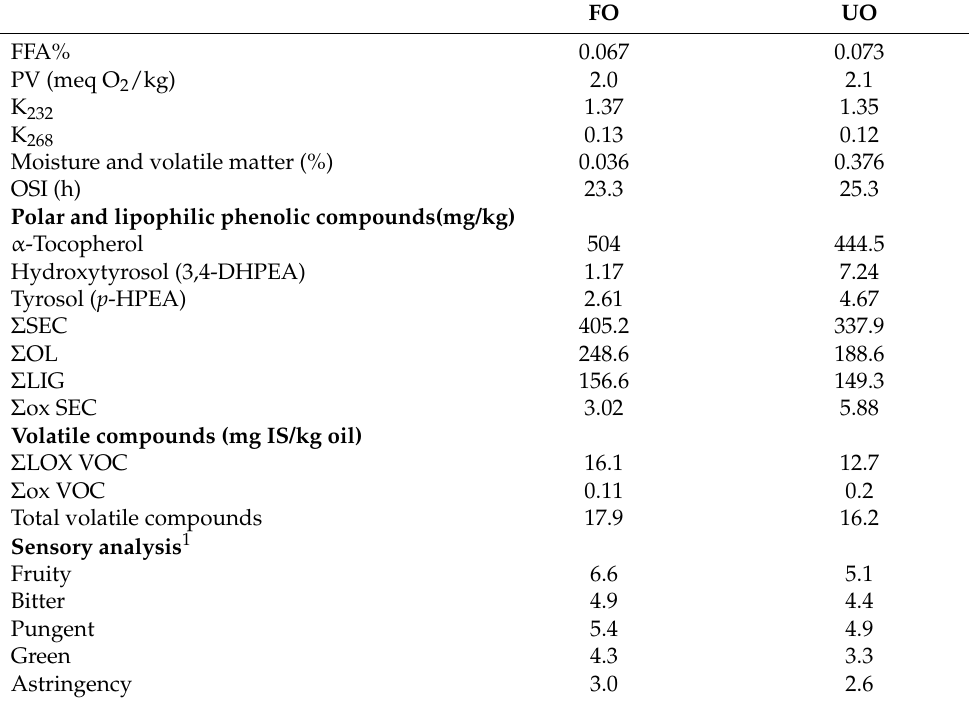
Table 1. Selected parameters of the initial characterization of the filtered (FO) and unfiltered (UO) oils in the study. Values correspond to mean values of two experimental replicates (all parameters were further determined in analytical duplicate, except for K 232 , K 268 and ∆ K which were determined in triplicate). The full initial characterization of the oils can be found in Supplementary Materials, Table